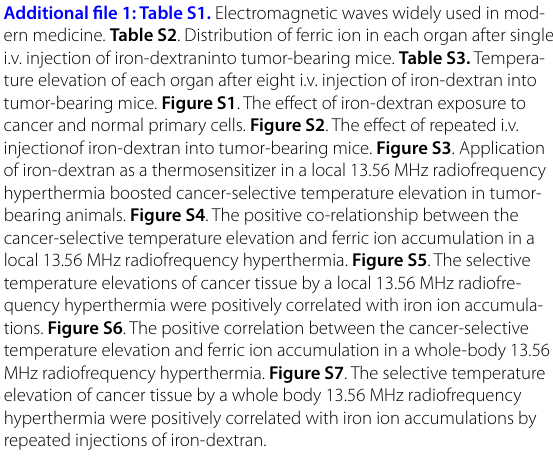
Additional file 1: Table S1. Electromagnetic waves widely used in mod‑ ern medicine. Table S2 . Distribution of ferric ion in each organ after single